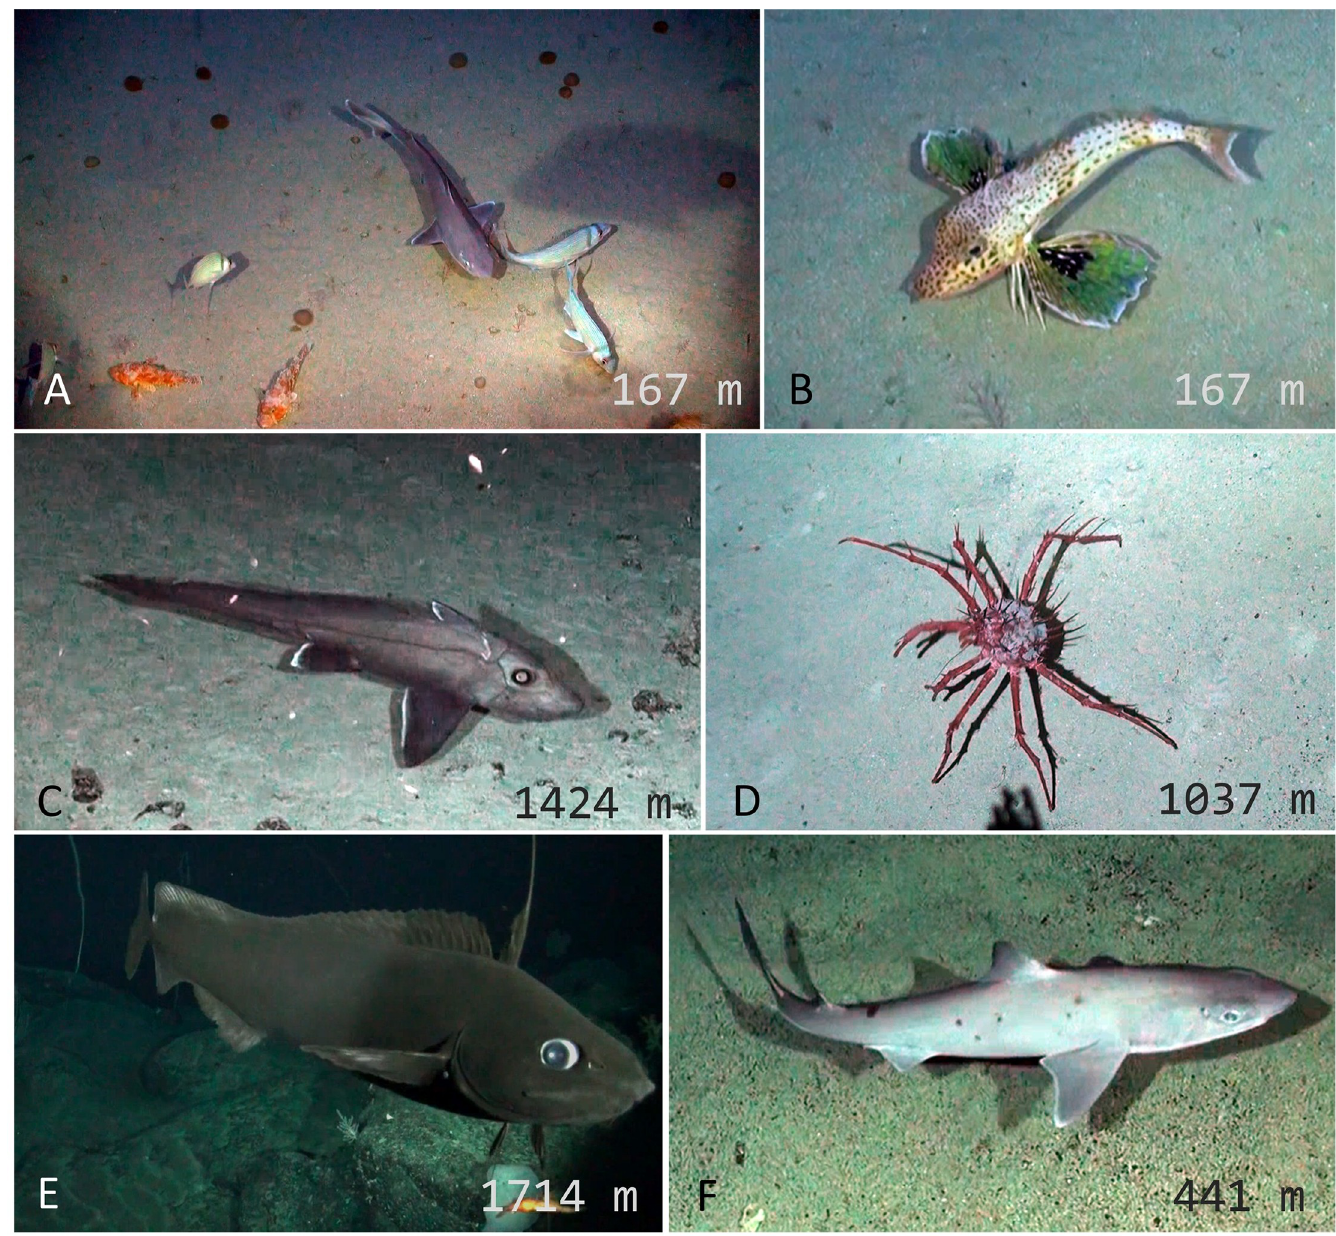
Fig 3. Representative and unique taxa observed with deep-sea camera systems at Desventuradas Islands. (A) Nemadactylus gayi � , Scorpaena orgila � , Squalus sp. (B) Pterygotrigla picta (C) Hydrolagus sp. (D) Lithodidae (E) Antimora rostrata (F) Squalus sp. � endemic species.